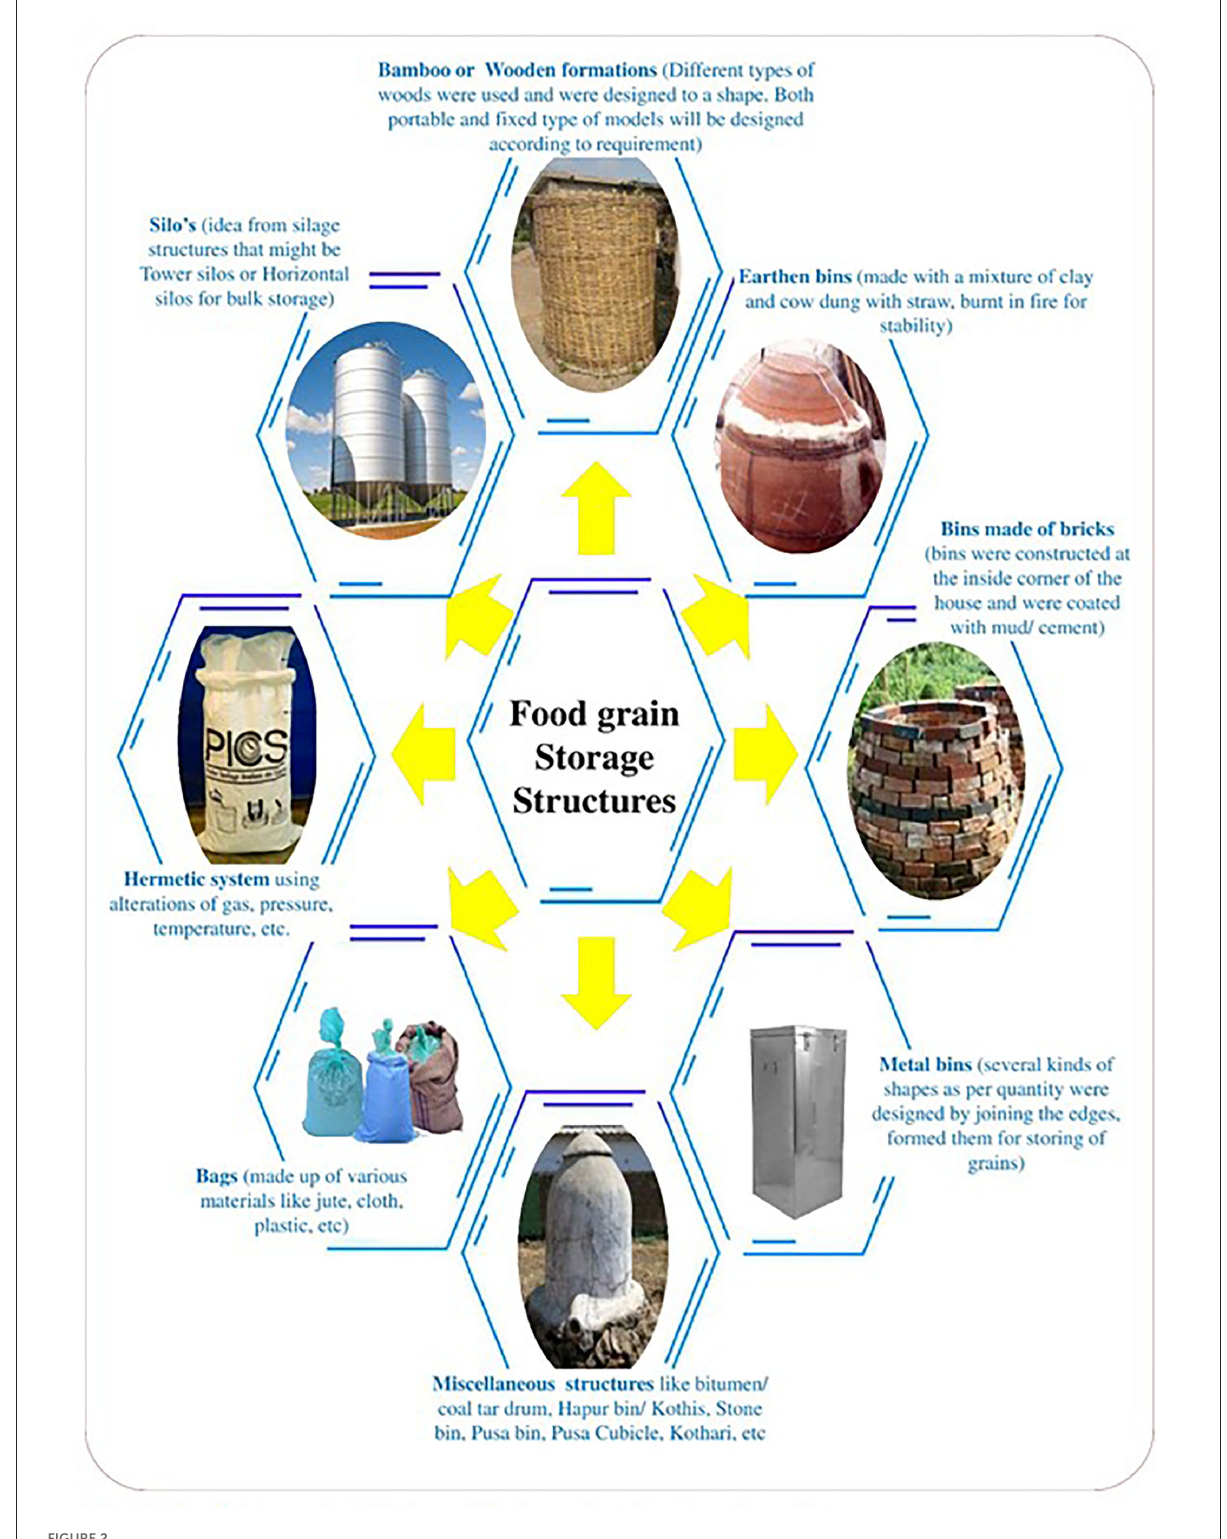
FIGURE2 Major categories of food grain storage